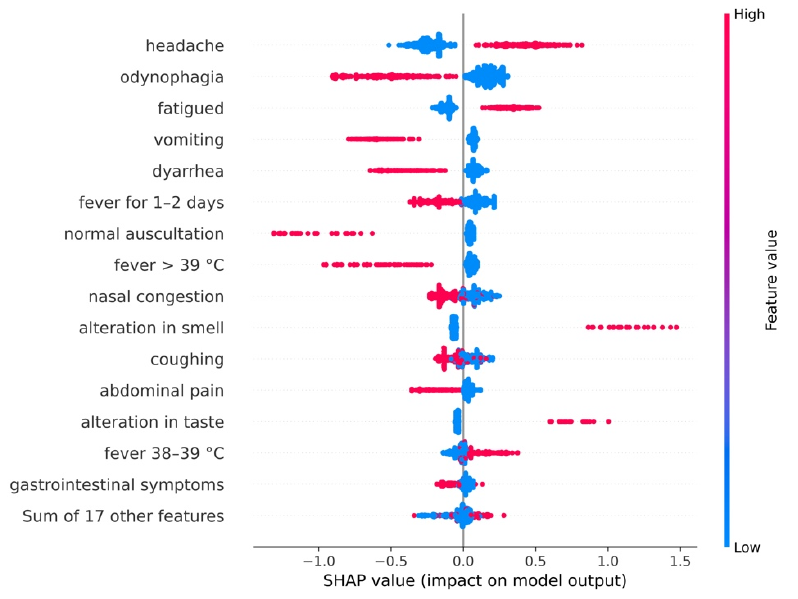
Figure 2. Impact of each variable on the model output for the general model. The features are organised top-down, by decreasing overall importance. For each feature, the SHAP value of each test observation is shown as a point. Each symptom is present if the colour of the point is red and absent if it is blue. The more to the right the points are, the more the output is associated with a SARS-CoV-2 infection.